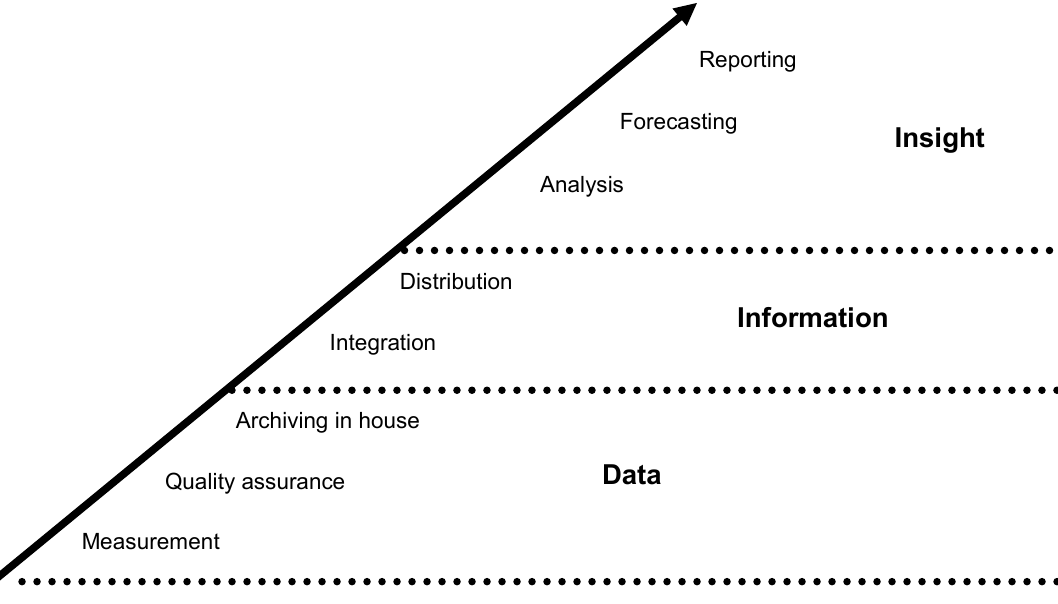
Fig. 1 Increasing value: Data >>> Information >>> Insight.